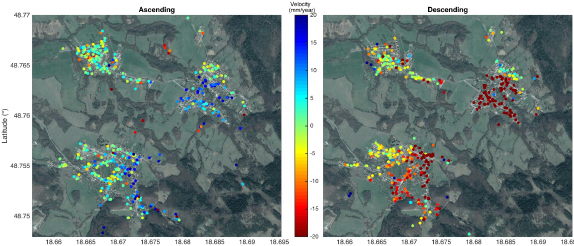
Figure 2. Deformation maps with mean LOS velocities obtained by PS InSAR analysis of Sentinel-1 radar imagery from ascending and descending track.